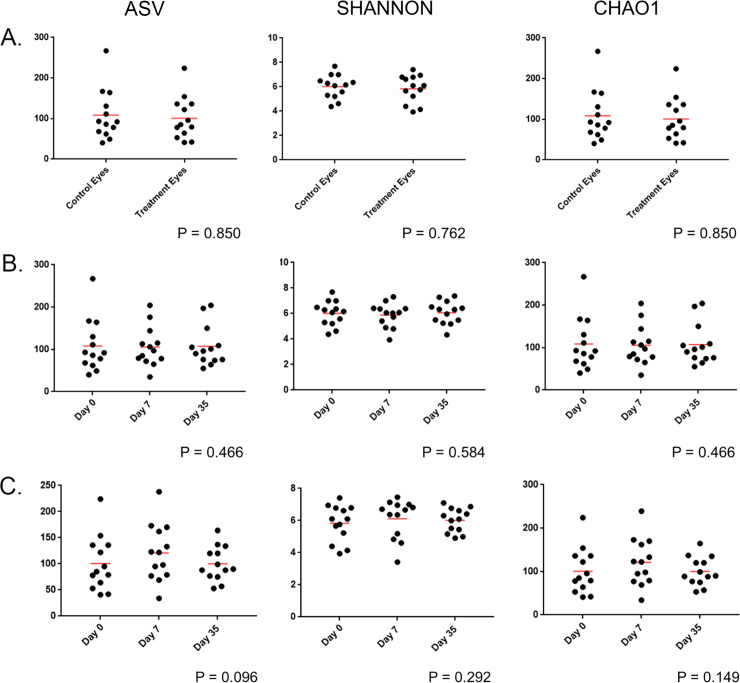
Scatter plots comparing alpha diversity results from (A) treatment and control eyes at baseline (day 0), (B) control eyes of healthy dogs (n = 13) at 3 time points: day 0, day 7, day 35, and (C) treatment eyes of healthy dogs (n = 13) at 3 time points: baseline (day 0), following one week of topical antibiotic therapy (day 7), four weeks after discontinued topical antibiotic therapy (day 35). Each dot corresponds to one eye from 13 healthy dogs. There is no difference in alpha diversity between control and treatment eyes at baseline (Wilcoxon match-pairs signed-ranks test). Alpha diversity did not differ in control eyes or treatment eyes over time (Friedman test and Dunn’s post-test).